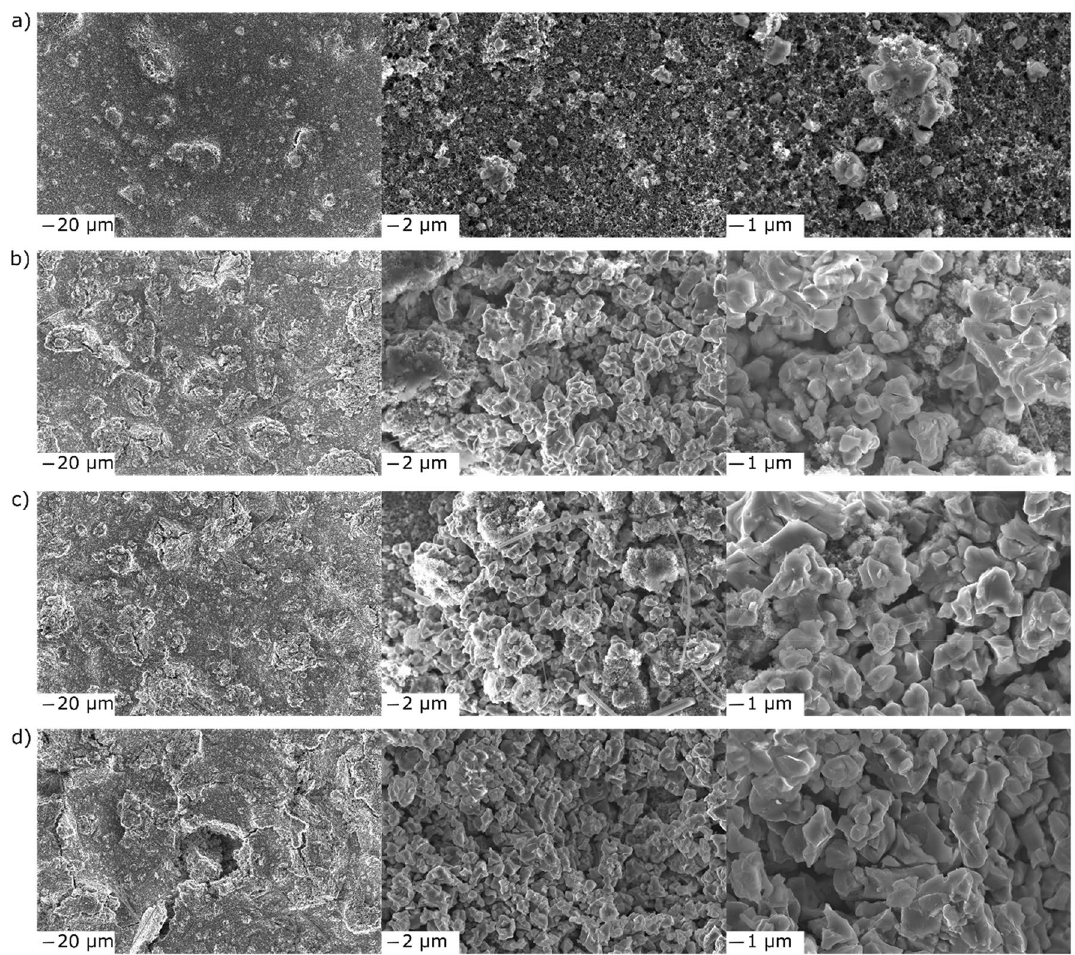
Figure 2. Top-view SEM images at different magnifications of the HEO anode ( a ) before cycling and ( b ) at 0.15 V, ( c ) 0.12 V and ( d ) 0.01 V vs Li + /Li in the initial lithiation